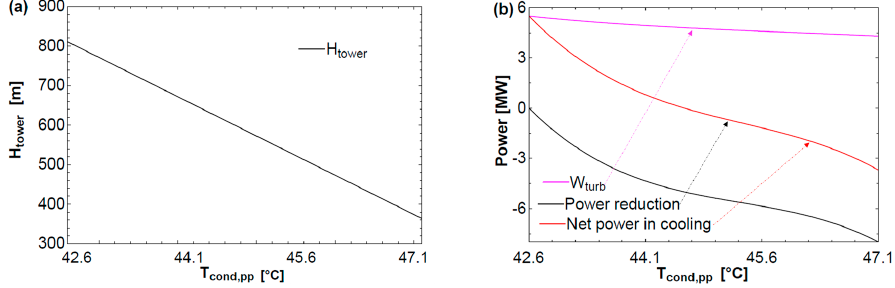
Figure 14. ( a ) Required tower height to maintain a power plant condensing temperature at varying Figure temperature; ( b ) net power for cooling.